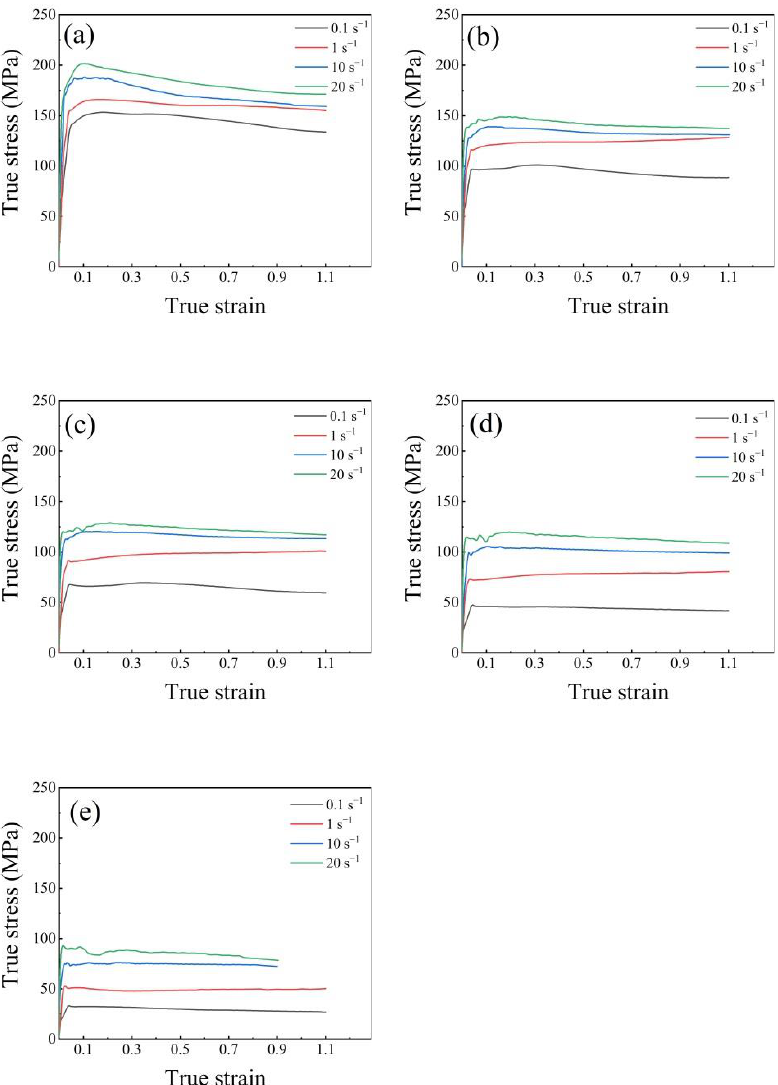
Figure 2. True stress–strain curves of Al-Zn-Mg-Cu alloy: ( a ) 573 K, ( b ) 623 K, ( c ) 673 K, ( d ) 723 K, ( e ) 773 K.